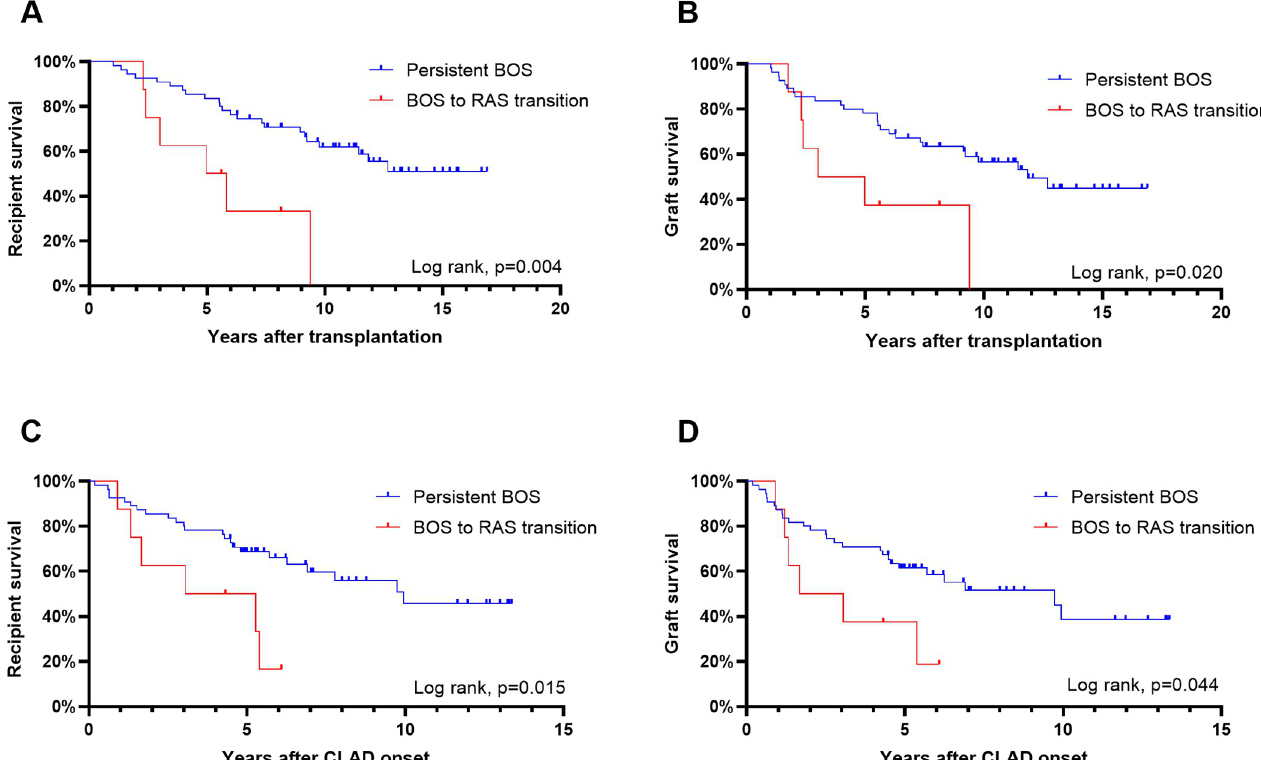
Fig 3. Impact of class change on survival. A) Recipient survival after lung transplantation, B) graft survival after lung transplantation, C) recipient survival after CLAD onset and D) graft survival after CLAD onset. Impact analyzed with Kaplan-Meier survival curves using the log rank -test. BOS: Bronchiolitis obliterans syndrome; CLAD: Chronic lung allograft dysfunction; RAS: Restrictive allograft syndrome.